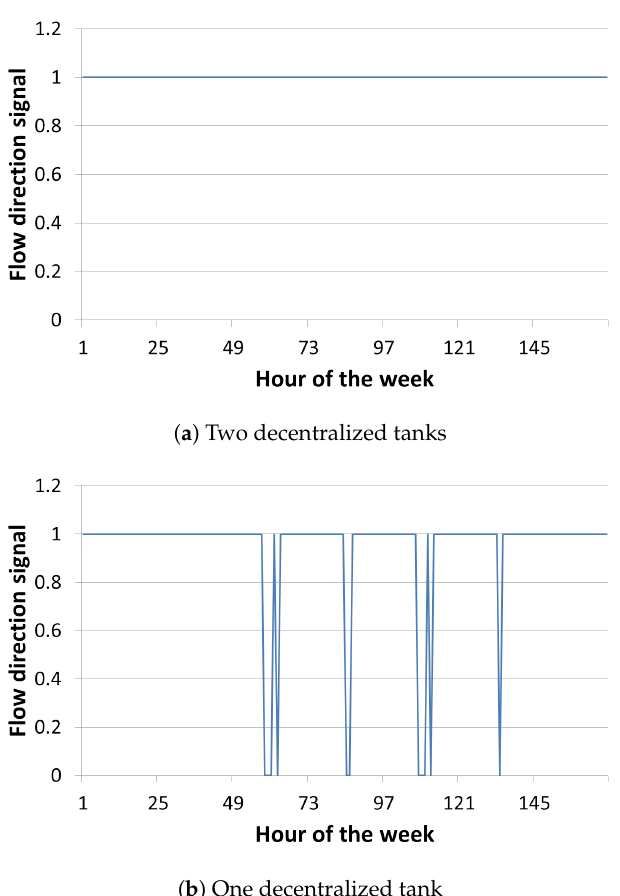
Figure 10. Flow direction signal in the district network for ENaQ retrofitted (first week of February).